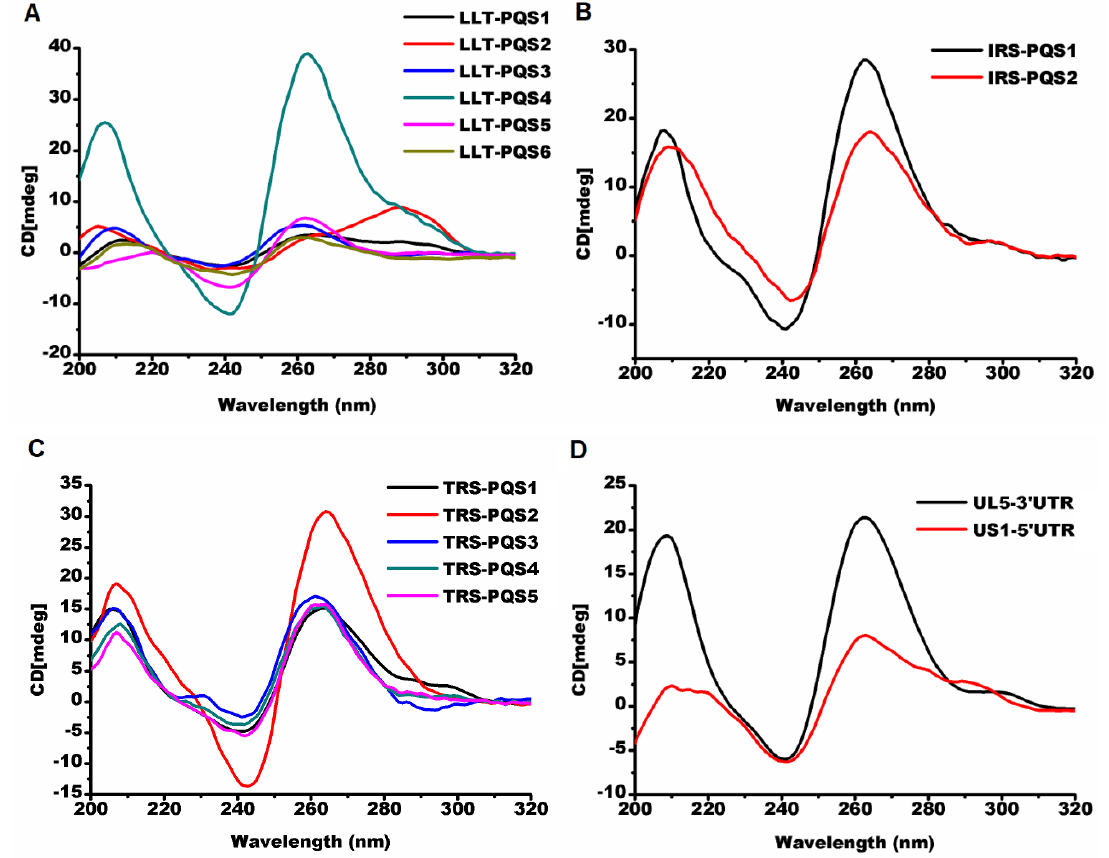
Figure 9. Circular dichroism (CD) spectra of G-quadruplex structures formed by selected oligonucleotides. ( A ) G 2 -PQS from the large latency-associated transcript (LLT) region. The LLT-PQS1 and LLT-PQS2 are located between the start site of LLT and the Prv-miR-1-5 ′ ; the LLT-PQS3, LLT-PQS4, LLT-PQS5, and LLT-PQS6 are located between Prv-miR-11-1 and the end of the LLT. ( B ) G 2 -PQS from the internal repeat sequence (IRS) region. The IRS-PQS1 and IRS-PQS2 are located between IE180 and US1 . ( C ) G 2 -PQS from the terminal repeat sequence (TRS) region. TRS-PQS1, TRS-PQS2, TRS-PQS3, and TRS-PQS4 are located in the sequence complementary to US1 CDS; TRS-PQS5 is located between IE180 and US1 . ( D ) G 2 -PQS from the untranslated region (UTR). The UL5-3UTR is from the 3′ U TR of the gene UL5 ; US1-5UTR is from the 5′ U TR of the gene US1 .